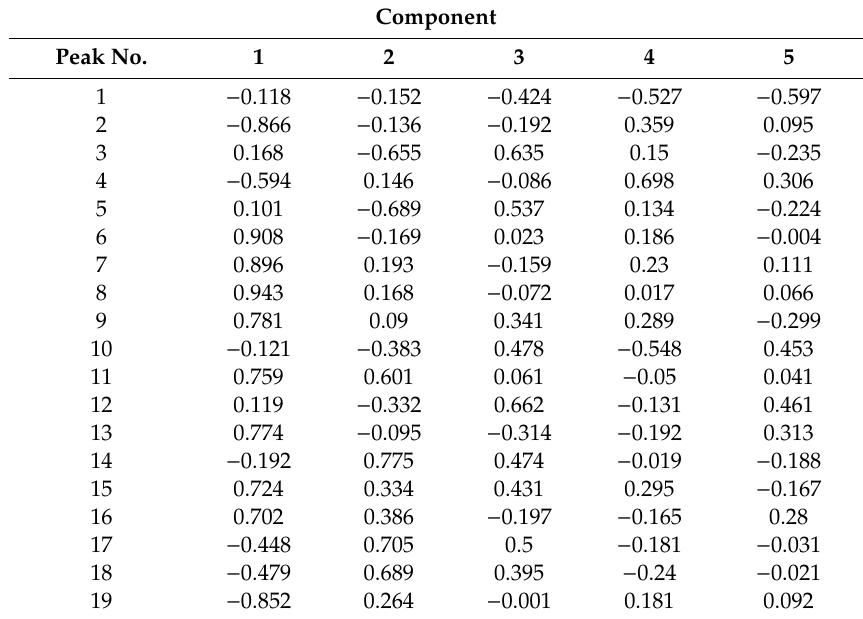
Table 3. Score coe ffi cient matrix of the chemical constituents.